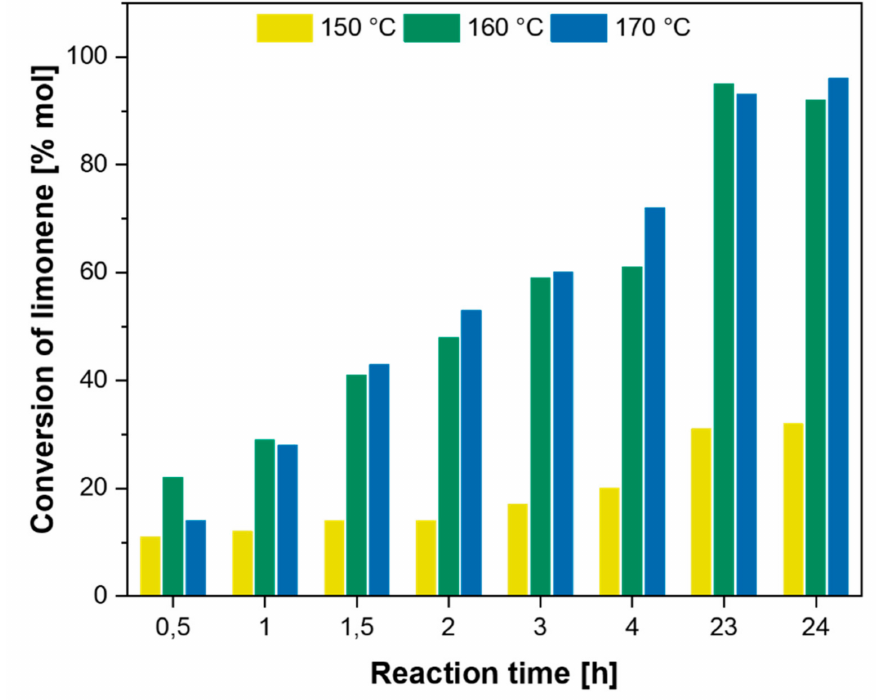
Figure 6. Temperature effect on the isomerization of R-limonene. Adapted with permission from Retajczyk et al. [43]. Copyright (2019)